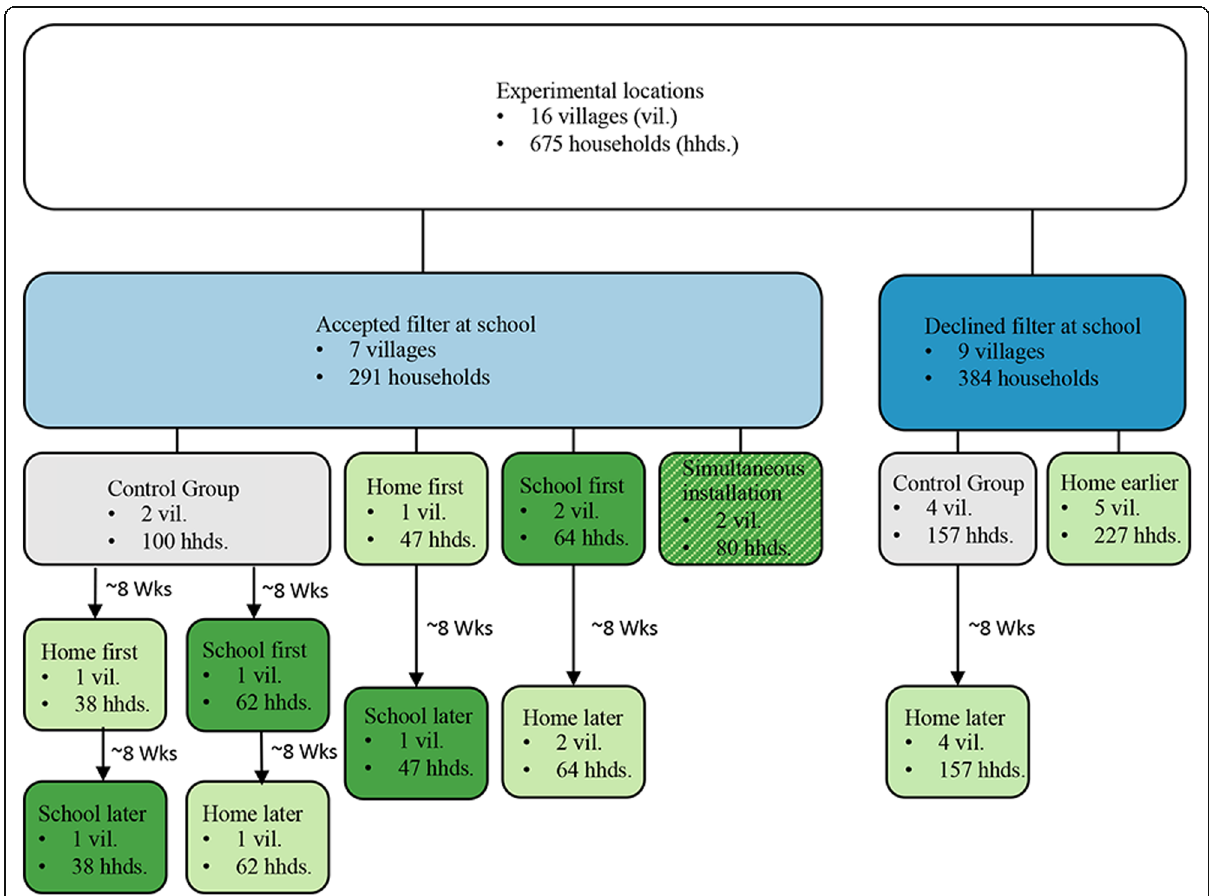
Fig. 2 Depiction of the assignment of schools and households to treatment groups. Depending upon whether the school in the village accepted or declined a filter, villages were initially assigned to either four or two treatment groups, respectively. In order to ensure that all households and schools that accepted a filter ultimately received one, secondary randomization of control group households was performed as depicted in the